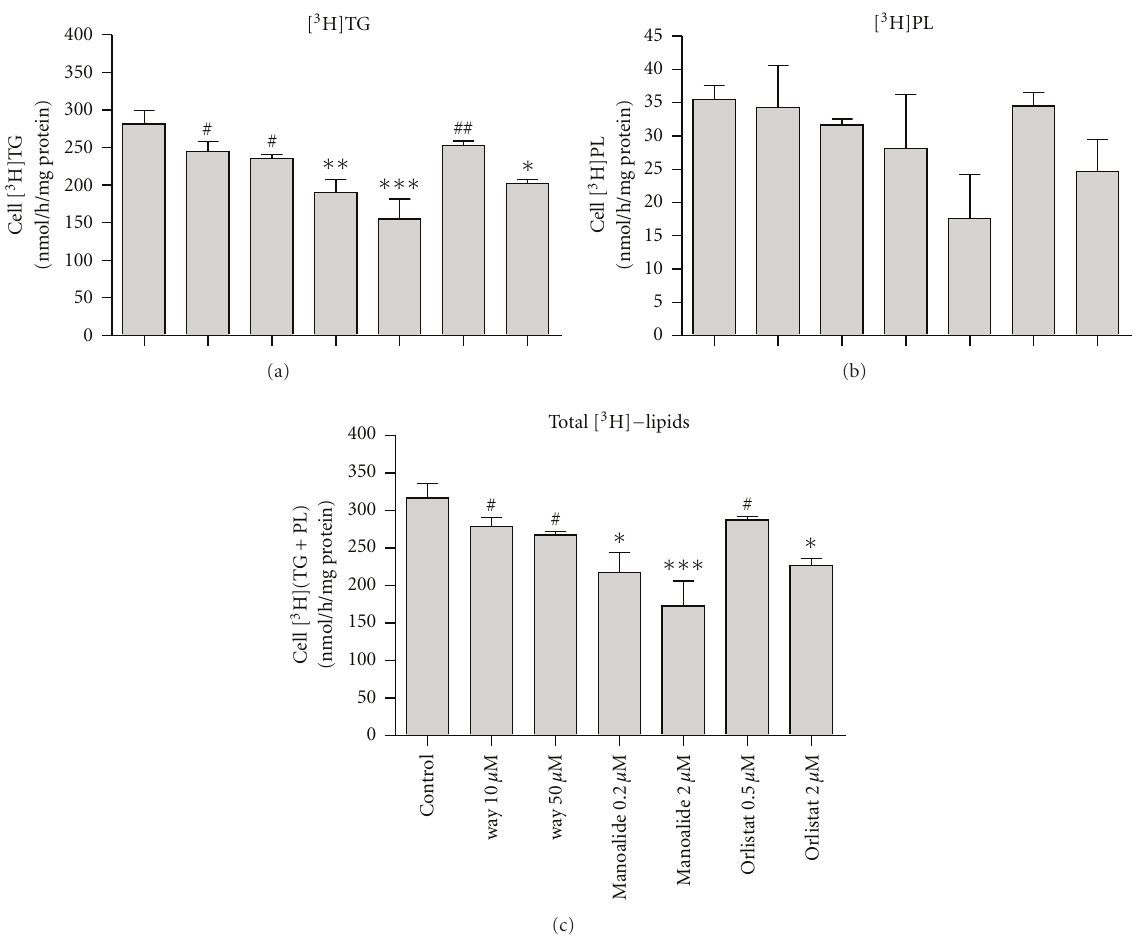
Figure 5: Role of macrophage-secreted lipases on [ 3 H]TG-CRLPw/o internalization. Cell radioactivity associated with macrophage lipids was determined after a 6-h incubation of HMDM with 80 μ g cholesterol/mL of [ 3 H]TG-CRLPw/o in the presence of 10 and 30 μ M way121.989 (way), 0.2 and 2 μ M of manoalide, 0.2 and 2 μ M of orlistat or in the absence of any inhibitor (control). Radioactivity associated with free fatty acids and cholesteryl ester was negligible, and that associated with macrophage triacylglycerol ([ 3 H]TG, (a)), phospholipid ([ 3 H]PL, (b)), and [ 3 H](TG+PL) (c) is reported as nmol/h/mg protein ( n = 3). ∗ P < 0.05, ∗∗ P < 0.01, ∗∗∗ P < 0.001 versus control; # P < 0.05, ## P < 0.01 versus manoalide 2 μ